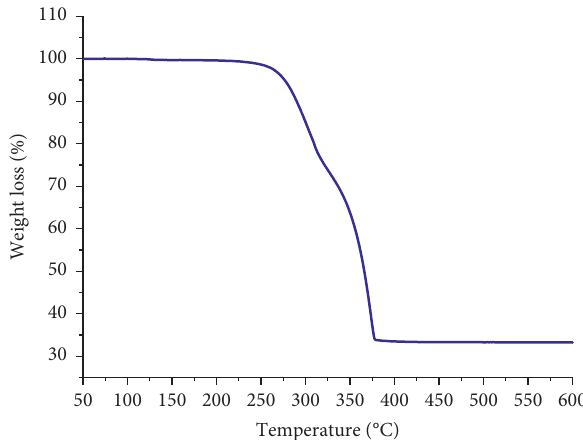
Figure 2: TGA profile for [Pb((SeP i Pr